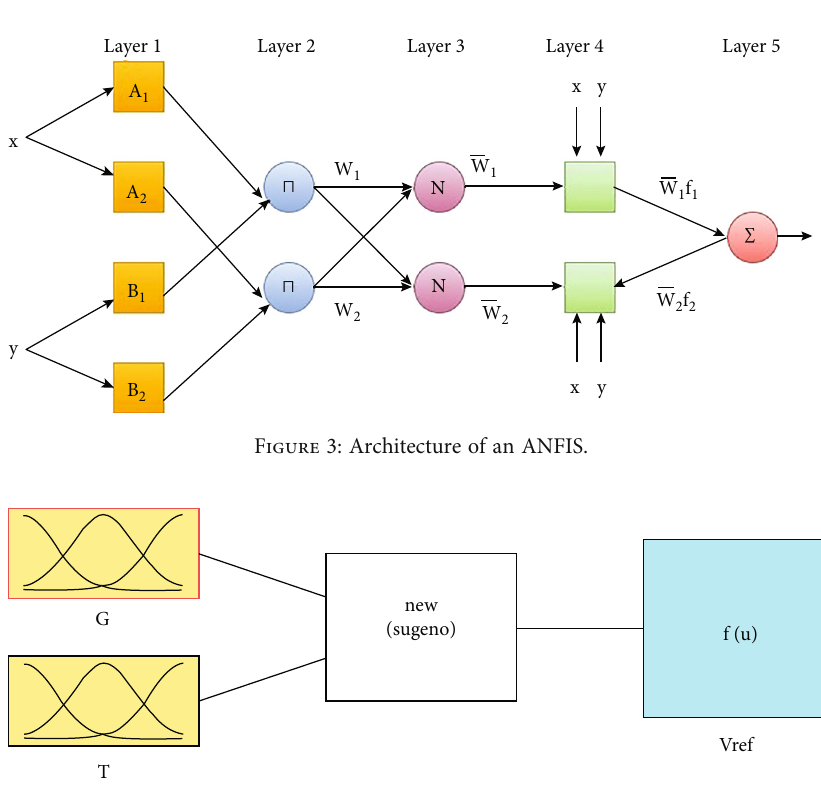
Figure 4: Proposed ANFIS MPPT